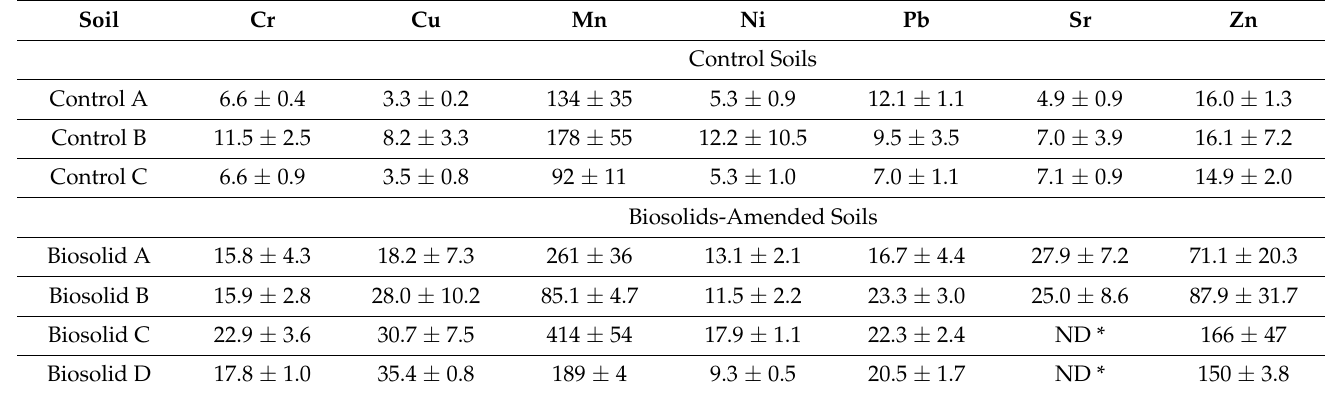
Table 3. Total trace elements (mg kg − 1 ) in control and biosolids-amended soils.